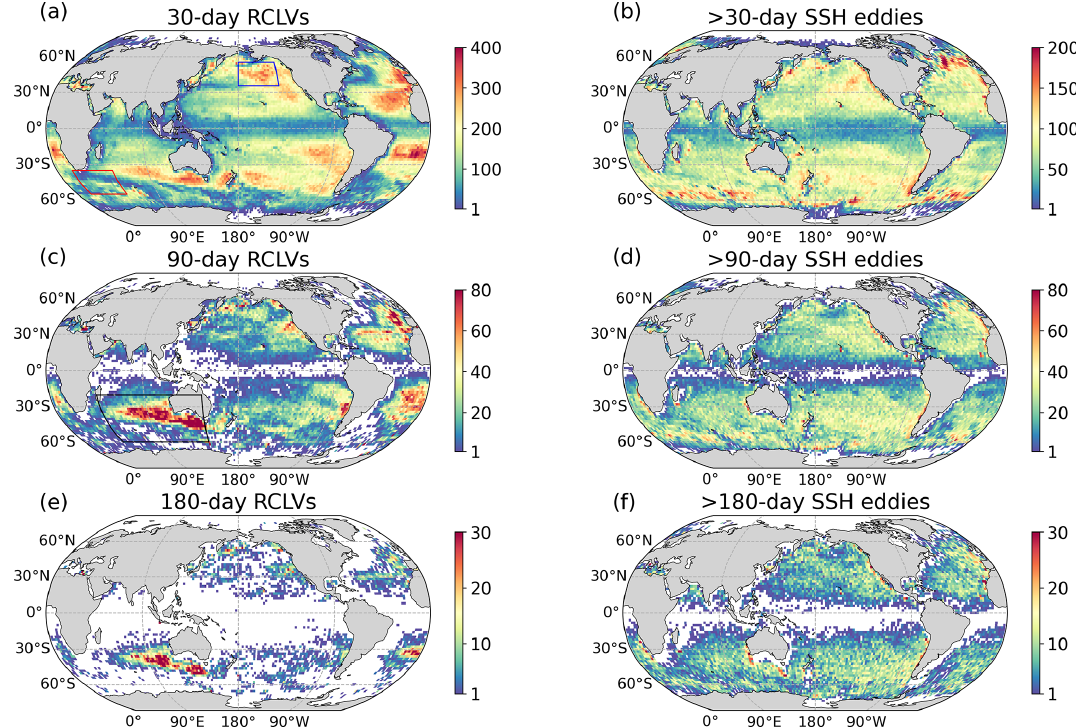
Figure 6. The geographic distribution of the eddy-generation number in 2 ◦ × 2 ◦ grids for ( a , c , and e ) RCLVs and ( b , d , and f ) SSH eddies over 27 years. Three time intervals (30, 90, and 180d) are considered, and the grid without eddies is masked.